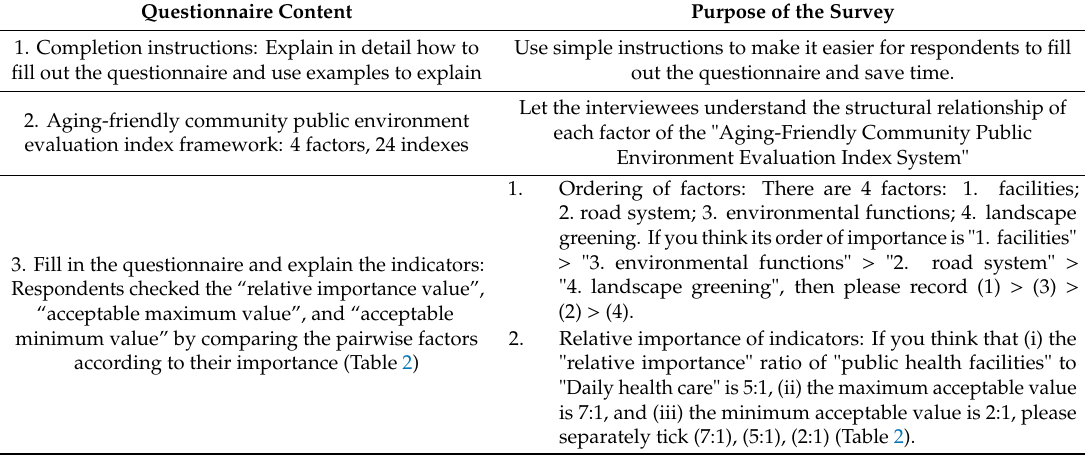
Table 1. Instruction Sheet for Filling Out the Fuzzy Hierarchy Analysis Expert